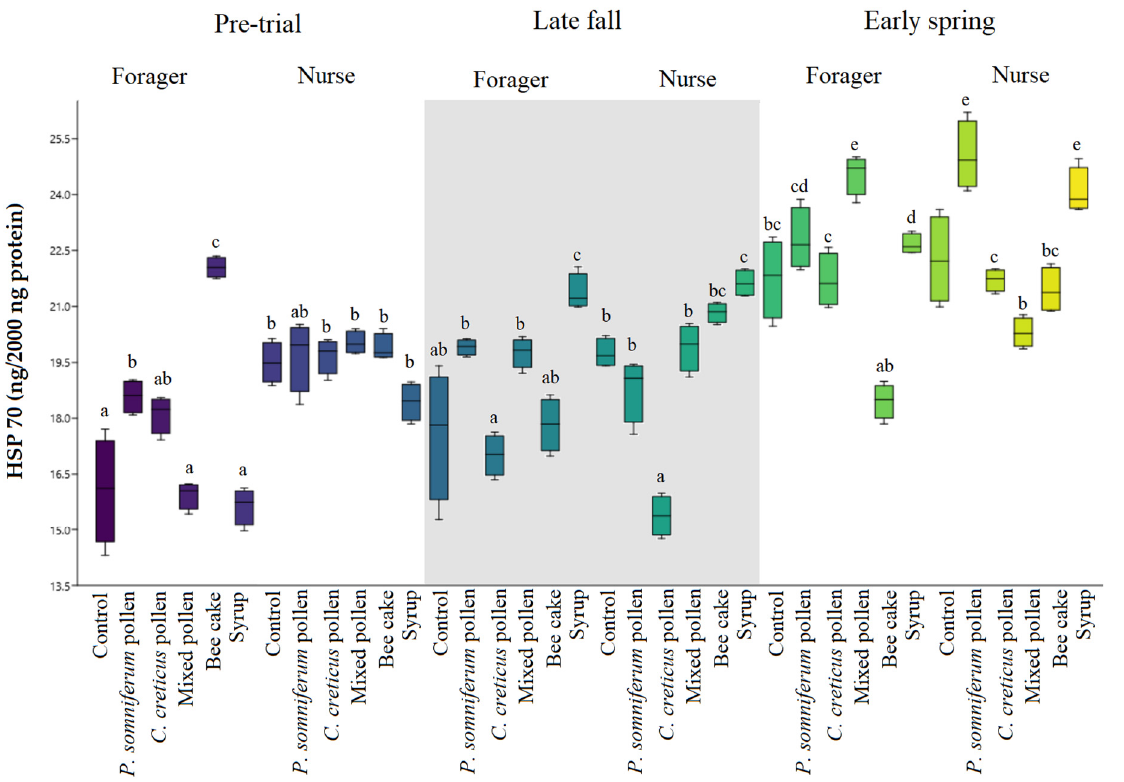
Figure 3. HSP 70 content/values of groups in late fall (Period 1) and early spring (Period 2). Different letters denote significant differences ( p < 0.05).